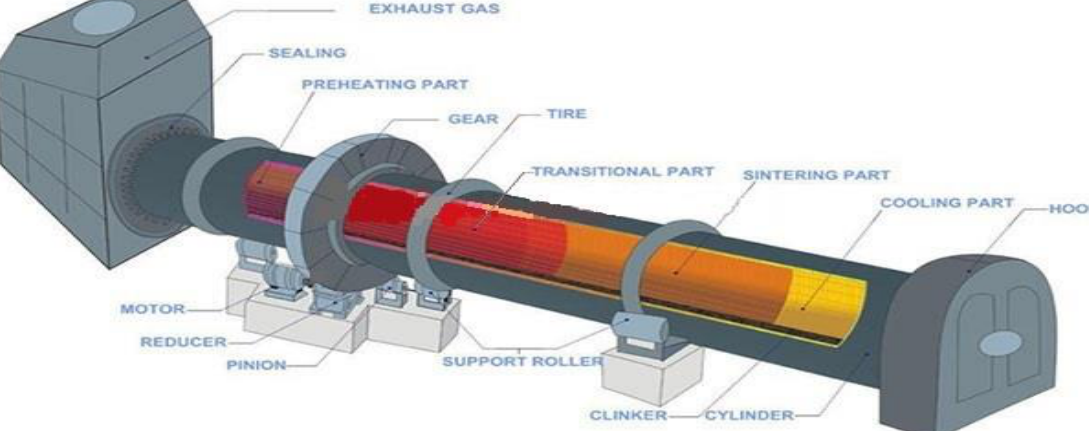
Figure 1. Schematic representation of cement production and rotary kiln operation